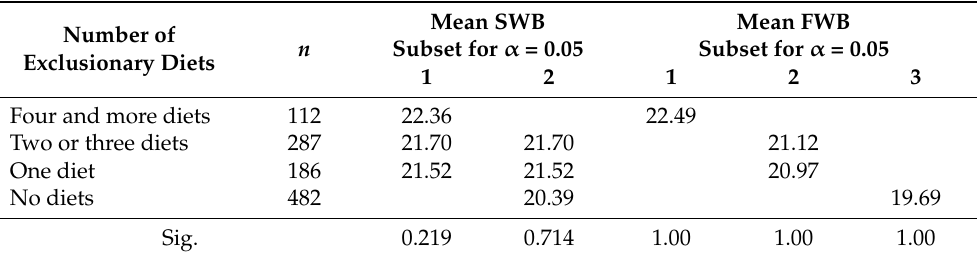
Table 4. SWB and FWB levels in the groups of respondents distinguished according to the number of diets followed.